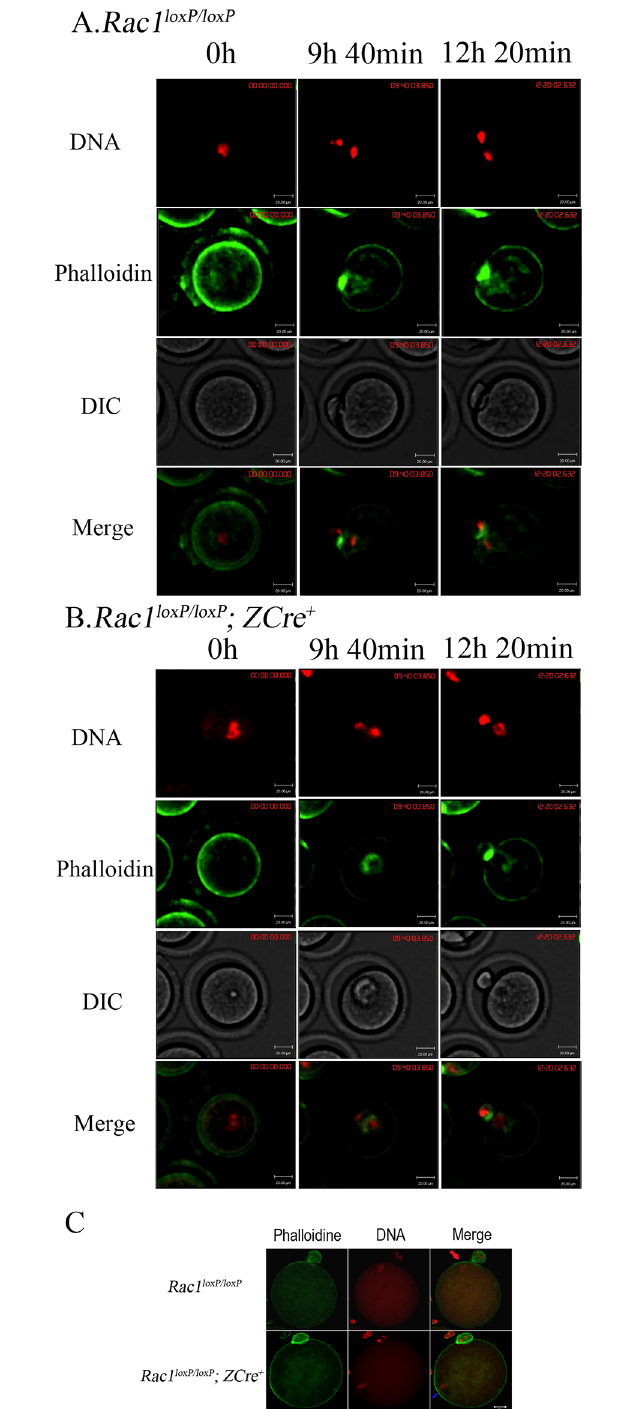
Fig 3. Rac1 deletion has no effect on oocyte maturation. For A and B, chromosomes were stainedin blue by Hoechst 33342 (2ng/mL in M16 medium)and the blue was changedinto red. Alexa 488-phalloidin was microinjected into GV oocytes to show the actin dynamics duringoocyte maturation. Bar = 20 μ M. (A) The dynamics of Alexa 488-phalloidin during Rac1 loxP/loxP oocyte maturation. (B) The dynamics of Alexa 488- phalloidinduring Rac1 loxP/loxP ; ZCre + maturation. (C) Normal actin cap in rac1 loxP/loxP ; ZCre + MII eggs. Oocytes were stained Alexa 488-phalloidine (green) and PI (10 μ g/mL, red), and viewedwith confocal microscopy. Bar = 20 μ M.